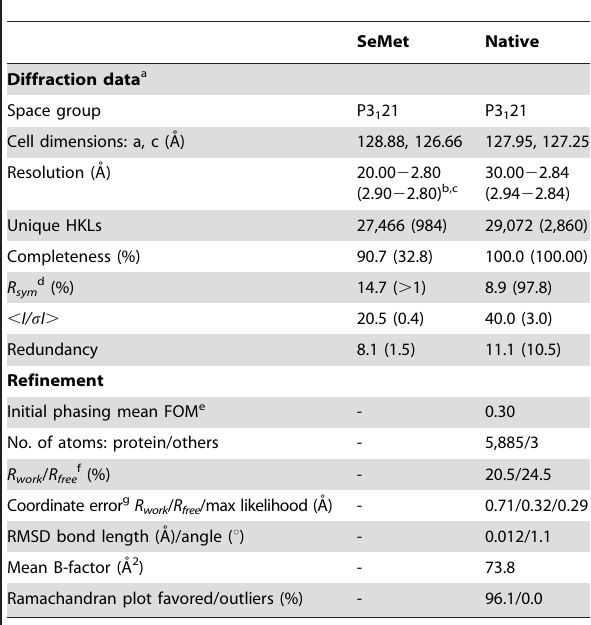
Table 2. Crystallographic data and refinement